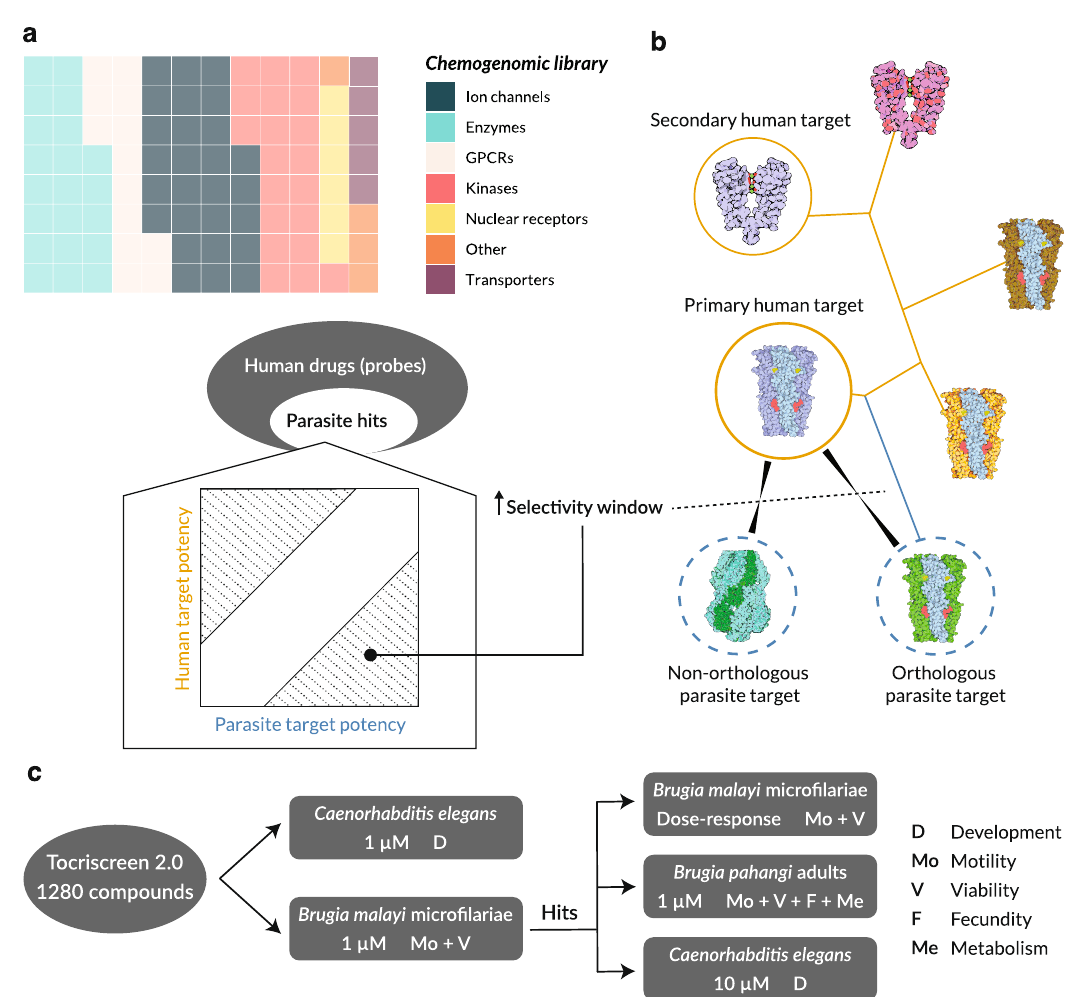
Fig. 1 Utilization of chemical probes to identify fi larial drug targets. a Schematic of how a chemogenomic library can be used to identify non-human drug targets. Chemical probes with known targets are used in a phenotypic screen against parasites. Hits against parasites have a theoretical distribution of relative potencies when compared to the human target; some will be more potent against the parasite target than the human target (bottom right shaded region) and others will be more potent against the human target (top left shaded region). b Known phylogenetic relationships among targets may help in deconvoluting the parasite target when it is orthologous to the primary human target, but it may also be the case that the parasite target is speci fi c to the parasite, in which case the known human target will be misleading. c Pipeline of the screening approach, incorporating a high-throughput bivariate screen against Brugia malayi micro fi lariae (mf) in parallel to a screen against Caenorhabditis elegans . Hits from the mf screen are then followed up for dose- response experiments in mf, a secondary multivariate screen against Brugia pahangi adult male and females, and additional screening against C. elegans at a higher concentration where